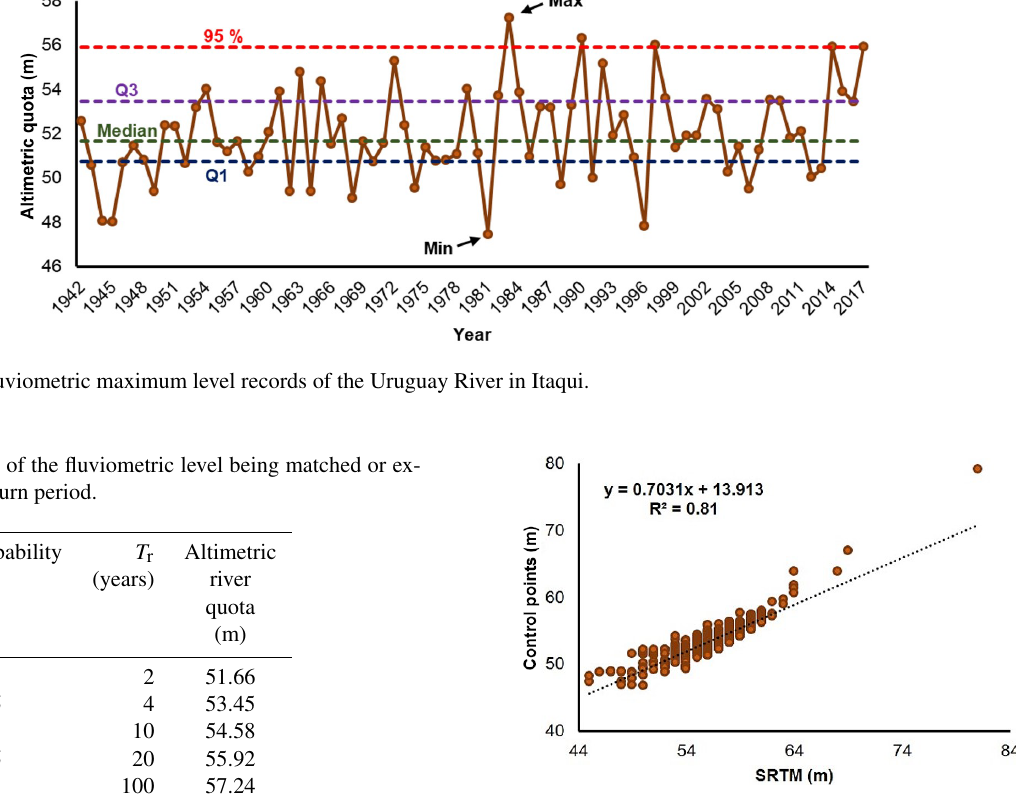
Figure 6. Linear regression analysis of SRTM image vs. ground control points (GCPs). Table 4. Indicators of DEM errors in relation to